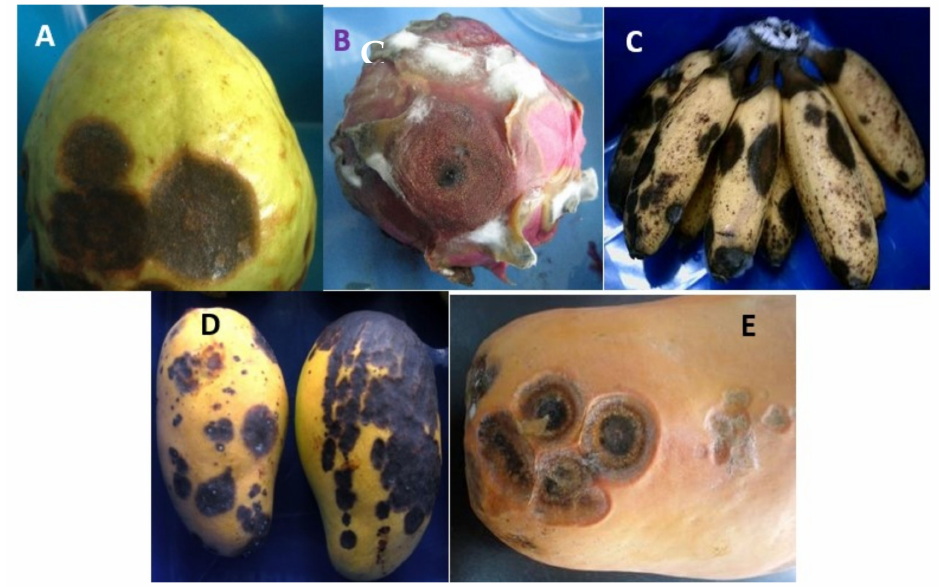
Figure 2. Anthracnose symptoms on several tropical fruit crops. ( A ) Guava, ( B ) dragon fruits, ( C ) banana, ( D ) mango, ( E ) papaya. (Photographs taken by Latiffah Zakaria and postgraduate